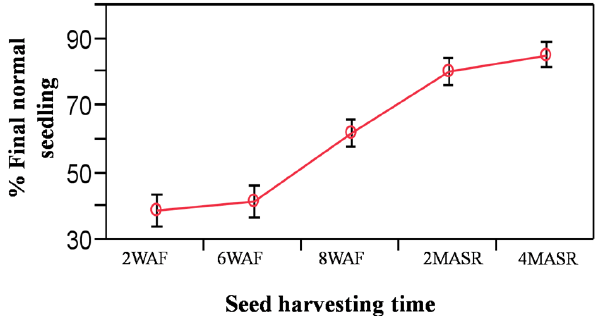
Fig. 4. Effect of different seed harvesting times on mean %final normal seedling in R. turcomanicus Czerep.